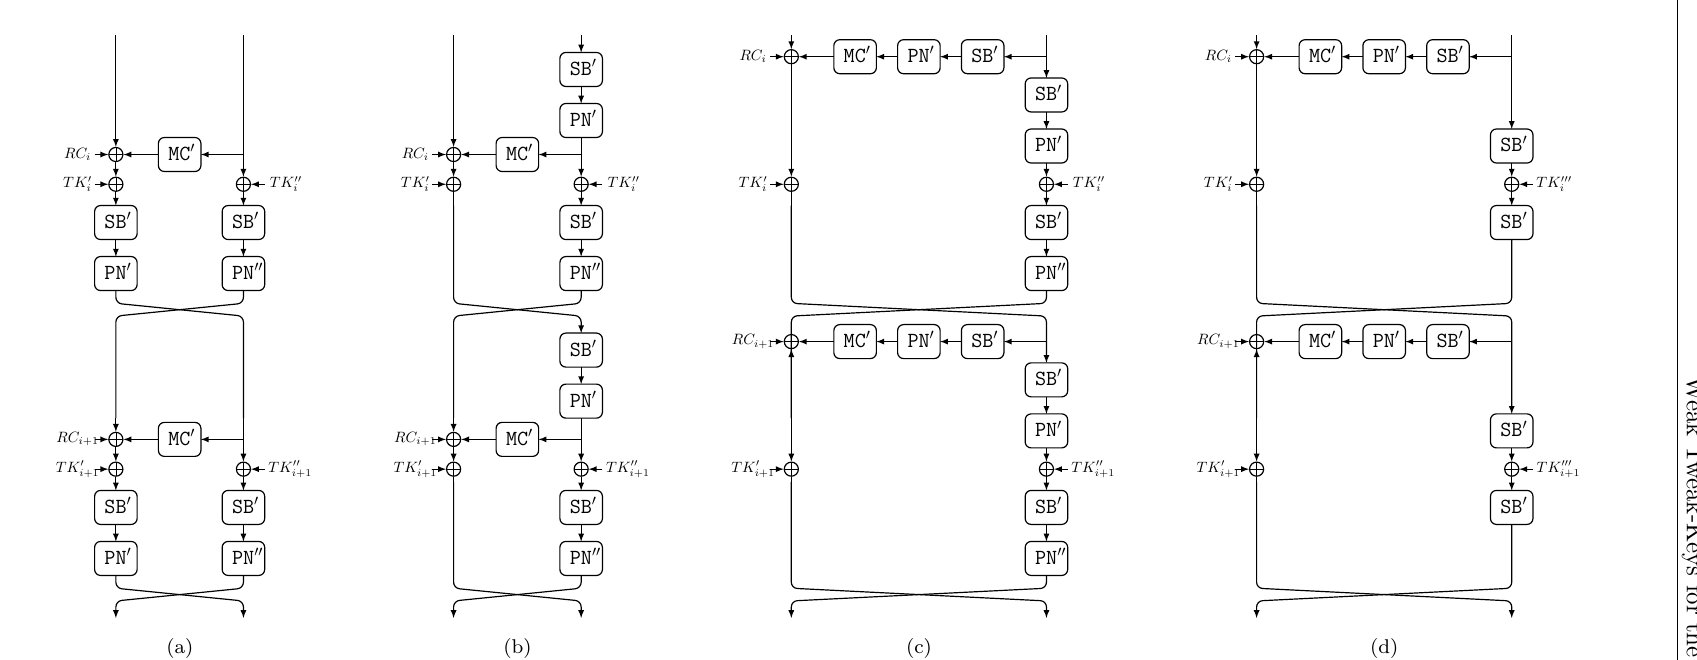
Figure 6: Transforming two representation rounds of CRAFT to two equivalent rounds: (a) two consecutive rounds, (b) bringing SB 0 and PN 0 from end of left branch of each round to the beginning of the right branch in the next round, (c) passing both SB 0 and PN 0 through the bridge point of each round, (d) removing both PN 0 and PN 00 in the right branch of each round by replacing TK 00